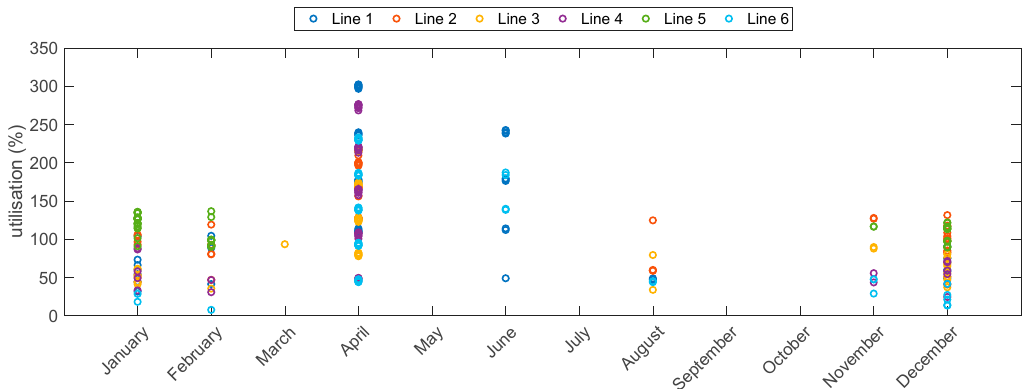
Figure 13. Month of occurrence for the maximum line utilisation of all scenarios with charging strategy 1 during the simulation period of one year.